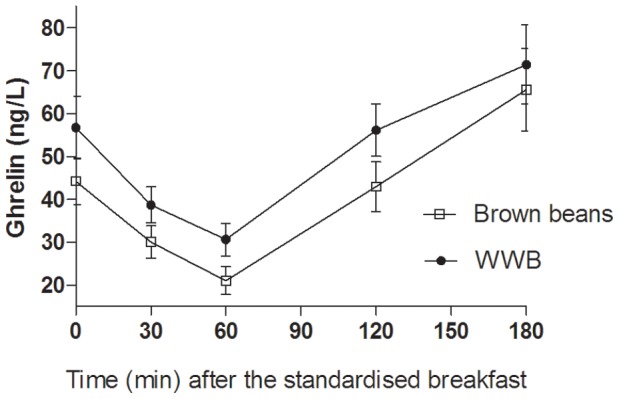
Concentrations of plasma ghrelin fasting and after a standardized breakfast, consumed 11 hours after evening meals composed of brown beans or WWB.A significant treatment effect (type of evening meal) was found over the test period (p<0.05, PROC MIXED in SAS release 9.2; SAS Institute Inc, Cary, NC). n = 16 subjects.